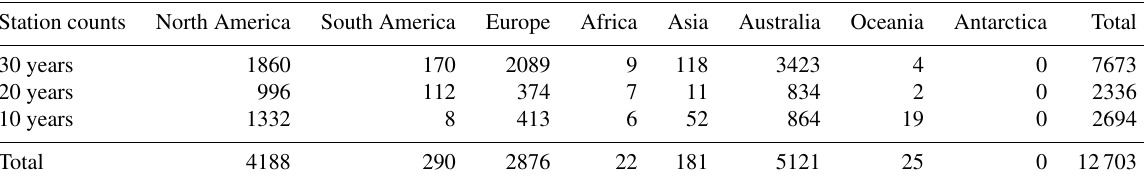
Figure 1. Coverage of the three international CLIGEN input datasets according to the record length used to produce the monthly input parameters. The locations correspond to those of the GHCN-Daily stations accepted for use. Table 1. Station counts for continent/region and each of the 30-, 20-, and 10-year datasets. Oceania is the region represented by South Pacific islands and extending north to